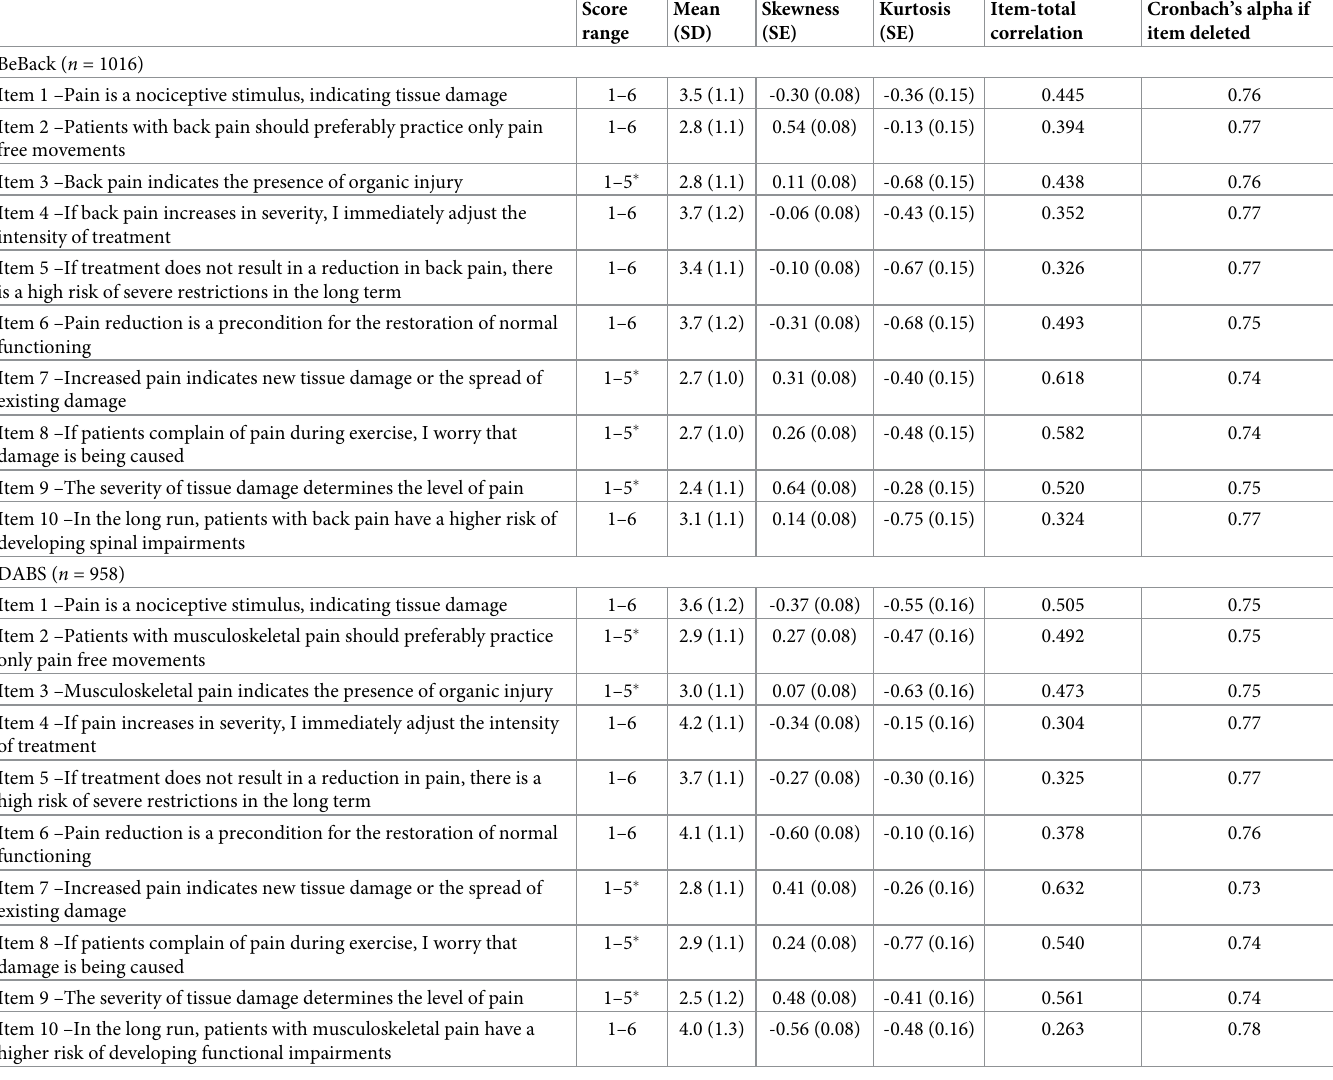
Table 2. Descriptive statistics for the 10 items of the biomedical scale of the Pain Attitudes and Beliefs Scale